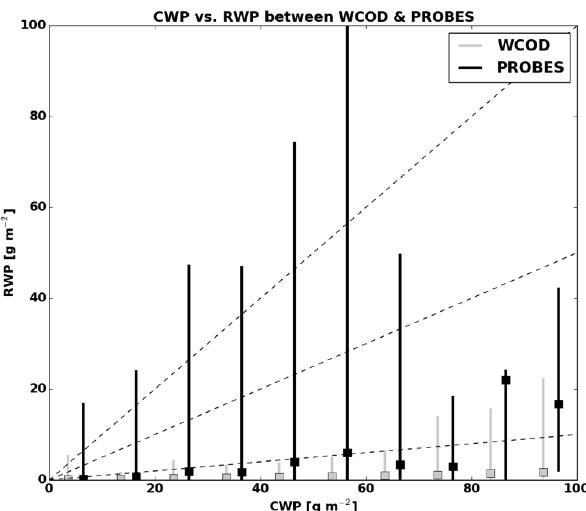
Figure 9. Distributions of RWP at various CWP amounts binned every 10gm − 2 , with boxes representing median values. Each set of lines represents 95% of all WCOD (light gray) or cloud probe (black) RWP estimates at the given CWP